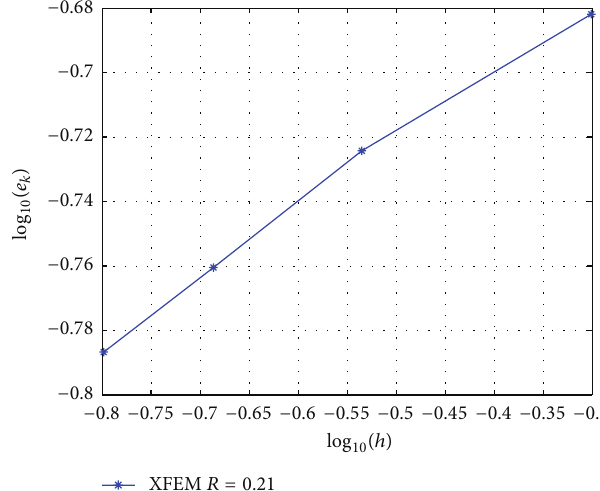
XFEM R = 0.58 Figure21:Theconvergenceinthestressintensityfactor 𝐾 𝐼 ofXFEM versus ℎ (mesh size) for a sheet with an edge crack under shear.